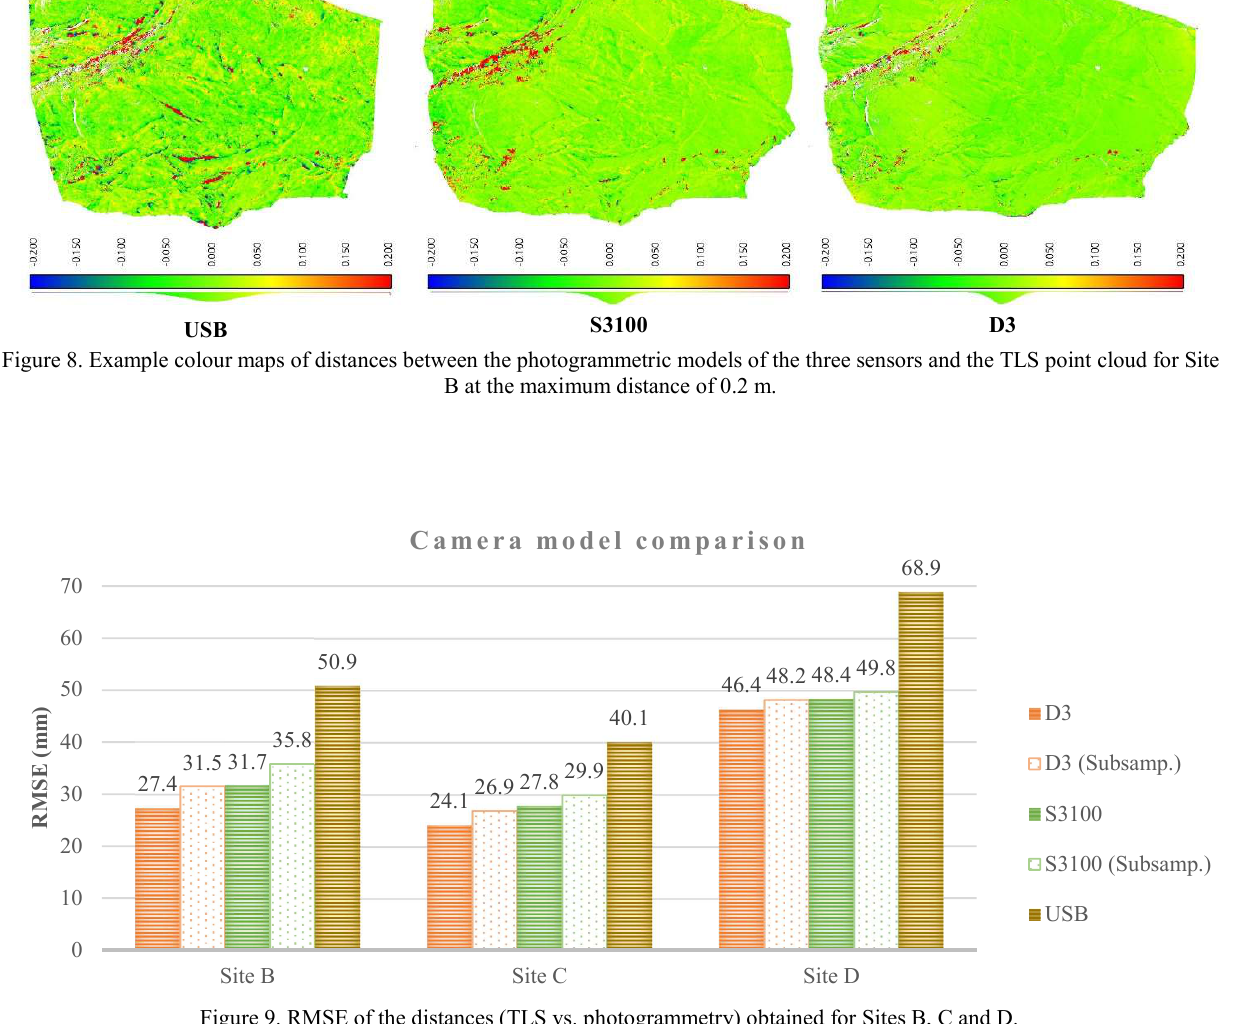
Figure 9. RMSE of the distances (TLS vs. photogrammetry) obtained for Sites B, C and